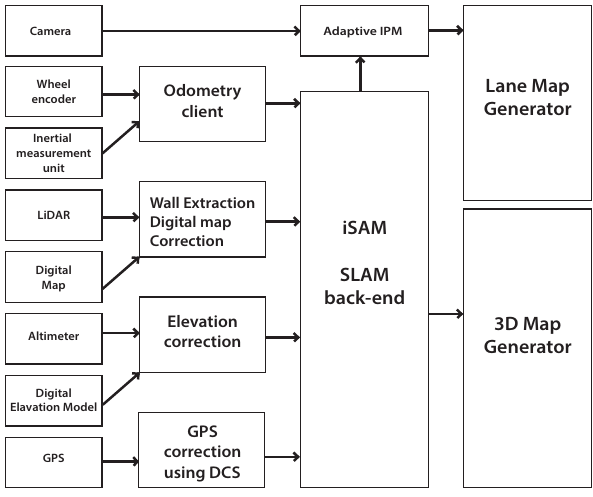
Figure 2. Software design diagram. The 3D point cloud map generation involves four main